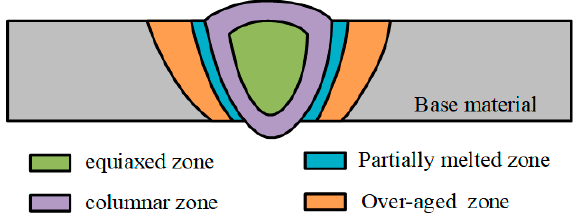
Figure 5. Diagrammatic drawing of the five distinct zones observed in the weld cross-sections of the hybrid welded joint (not to scale).